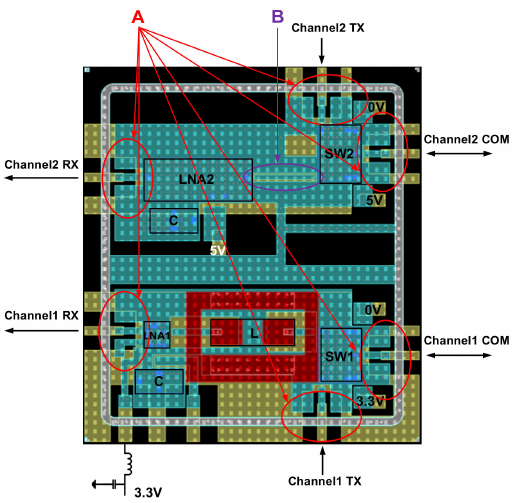
Figure 13. Top view of the layout of the double stacked RF front-end